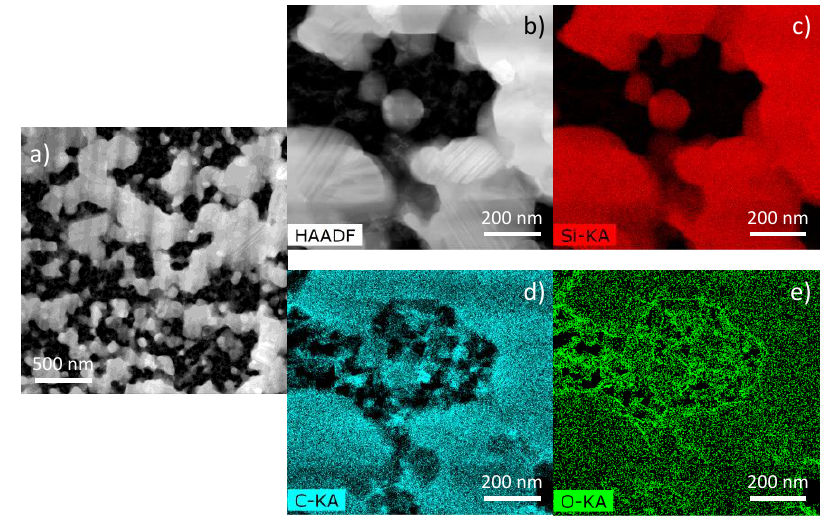
Figure 2. ( a ) STEM/HAADF general view of the cross-linked and pyrolyzed methylphenylvinylhydrogen polysiloxane preceramic polymer sample; ( b ) Detailed view in STEM/HAADF mode; ( c ) Associated EDS map for Si; ( d ) Associated EDS map for C; ( e ) Associated EDS map for O. STEM: scanning transmission electron microscopy; HAADF: high angle annular dark field; EDS: energy dispersive spectroscopy.